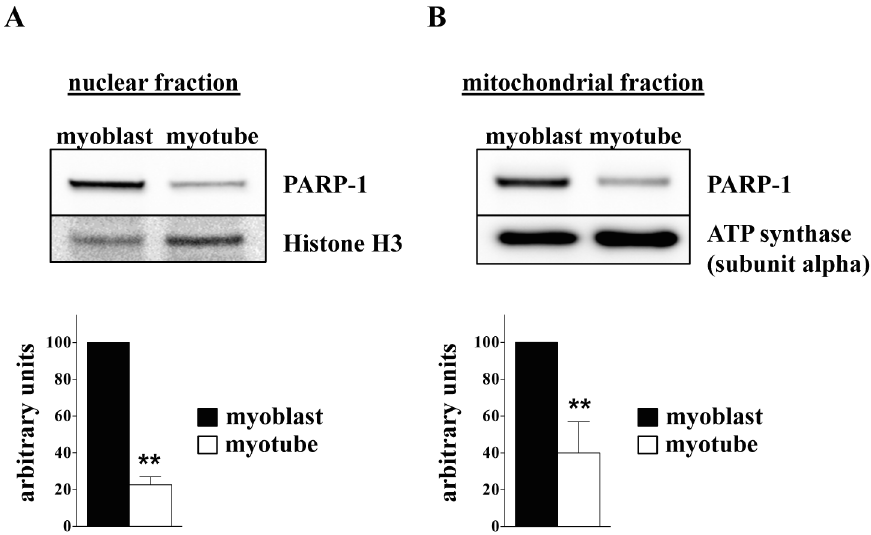
Fig 9. PARP-1 protein levels in mitochondrial and nuclear fractions of myoblasts and myotubes. Western blot analysis detected elevated expression of PARP-1 in myoblasts than in myotubes for both nuclear (A) and mitochondrial (B) fractions. Densitometric analysis of PARP-1 protein level in myoblast was set as 100%. Statistical analyses of n = 3 independent experiments were assessed; where ** indicates p <